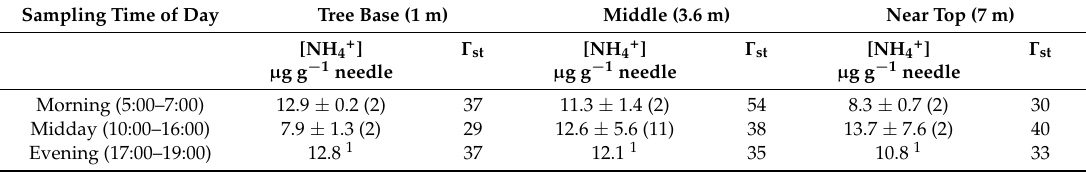
Table 2. Averaged [NH 4+ ] bulk from a single mature Ponderosa pine on 16-18 August 2018. Sampling Time of